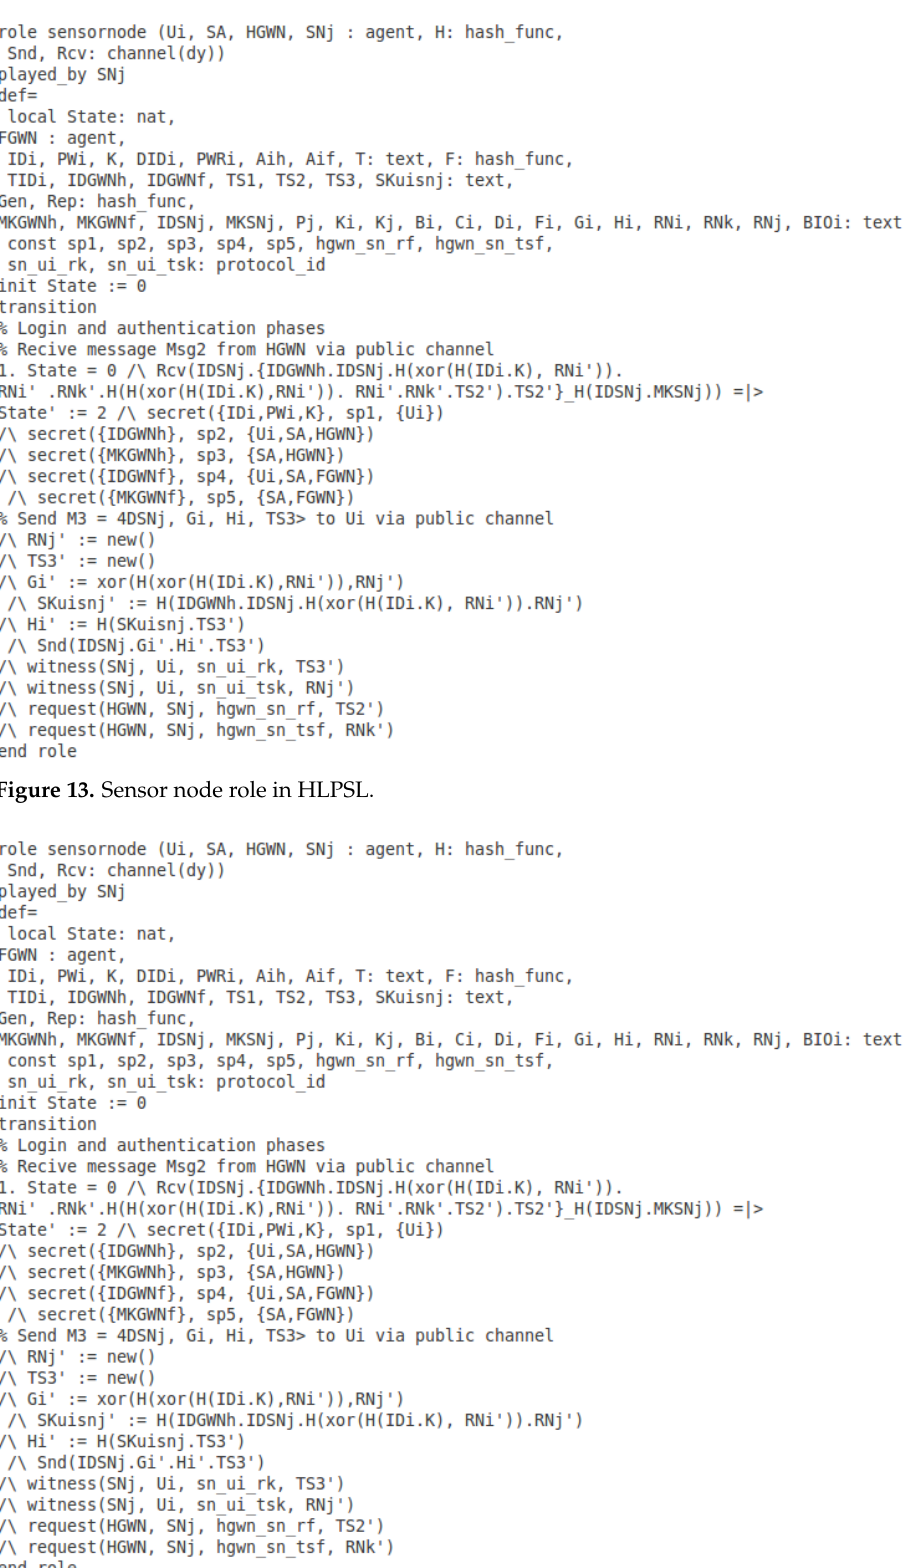
Figure 14. System administrator role in